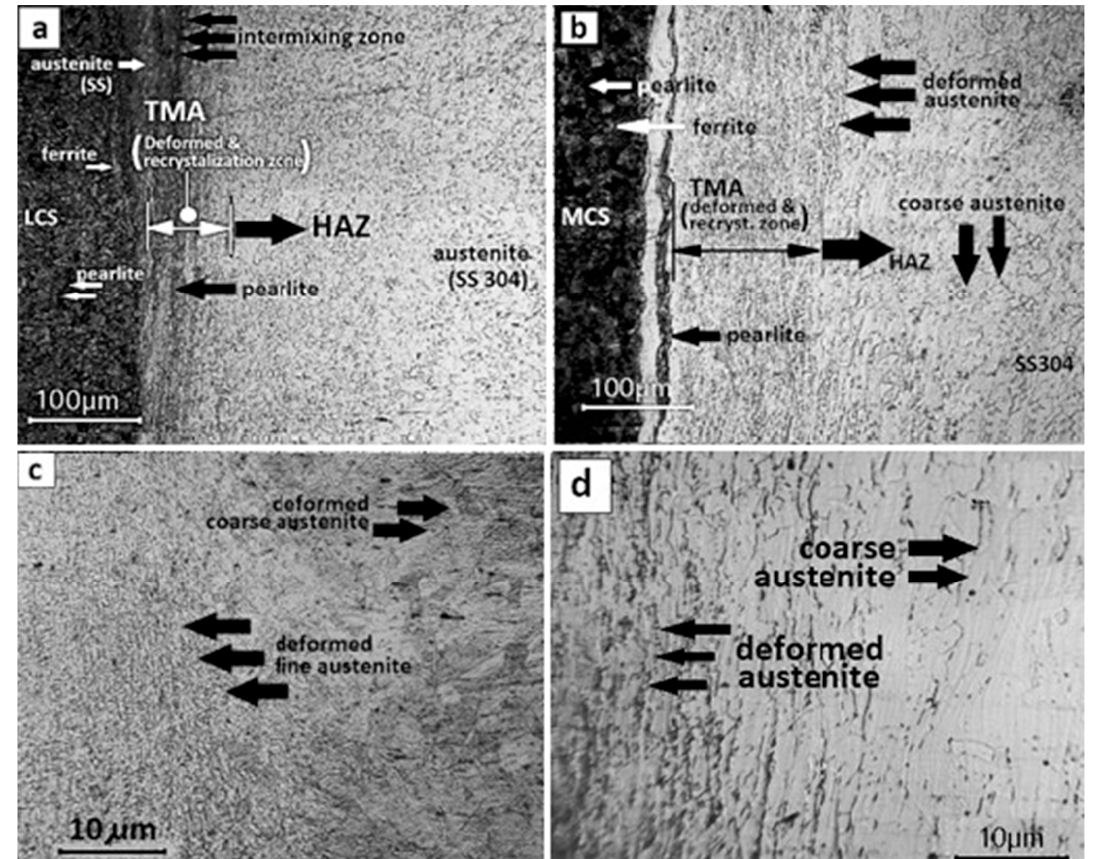
Figure 5. Microstructure of the interface at the joint of carbon steel–304 SS: ( a ) low-carbon steel–304 SS joint; ( b ) medium-carbon steel–304 SS joint; ( c ) enlarged view of deformed structure at TMA and coarse austenite in HAZ in low-carbon steel–304 SS joint; ( d ) enlarged view of deformed structure and coarse grain of austenite in HAZ in medium-carbon steel–304 SS joint.